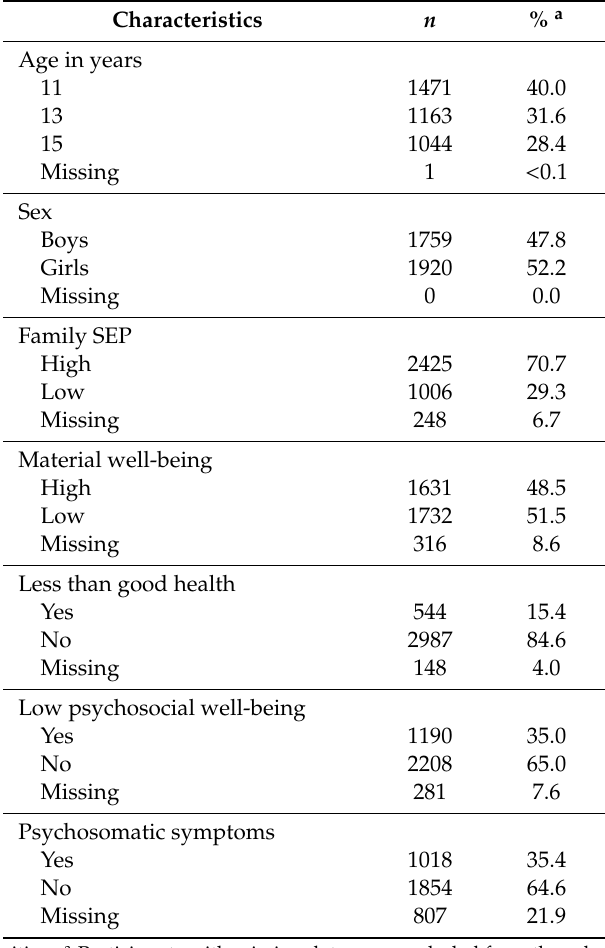
Table 1. Characteristics of adolescents ( n = 3679